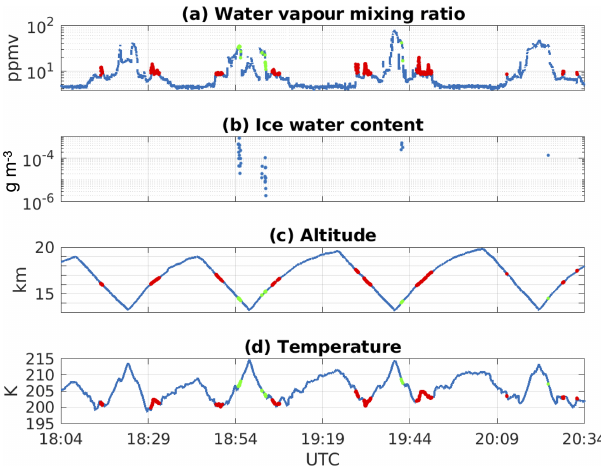
Figure 2. ER-2 aircraft observation of (a) water vapour mixing ra- tio in ppmv in logarithmic scale, (b) ice water content in gm − 3 , (c) altitude in km and (d) air temperature in K on 27 August 2013. The red dots highlight the measurements with pressure lower than 115hPa (tropopause) and water vapour volume mixing ratio greater than 8ppmv. The green dots highlight the measurements with the presence of